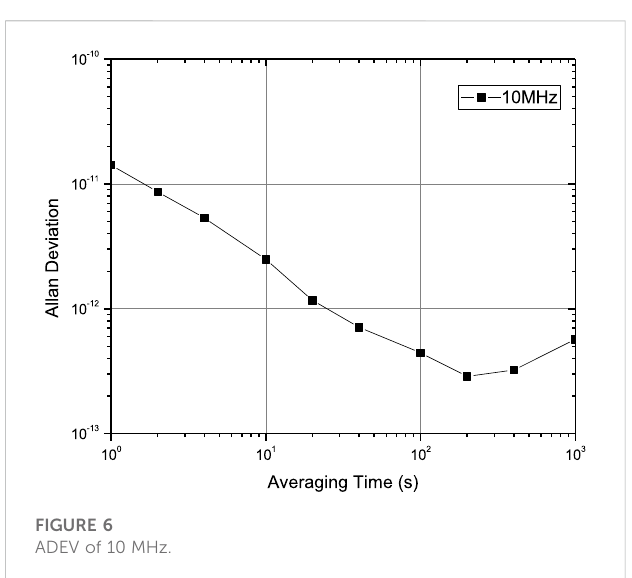
FIGURE 6 ADEV of 10 MHz.